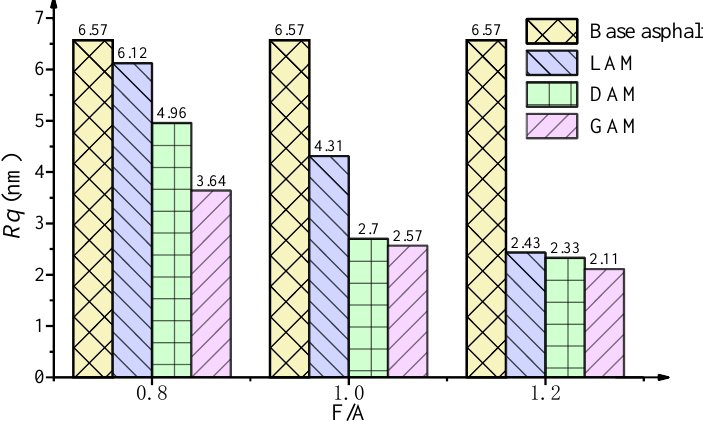
Figure 11. Results of the Rq surface roughness.